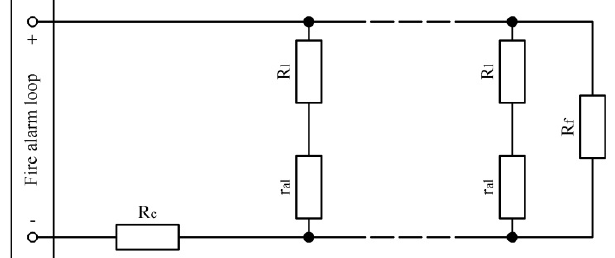
Figure 14. Equivalent electrical circuit of the FAL when two smoke FA with normally open contacts are